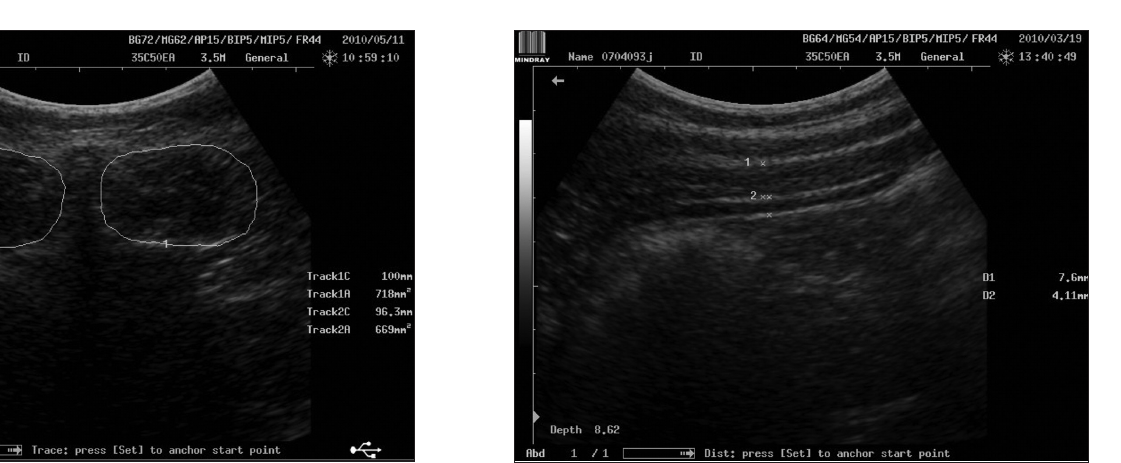
Figure 1: Image of Lumbar Multifidus at L4 with Ultrasound Imaging In the above image the internal caliper of the ultrasound unit was used to trace the circumference. This was 100mm (10cm) for the right side of the LM, from which a CSA of 718mm² (7.18cm²) is estimated. On the left side the circumference was 96.3mm (9.63cm) and the CSA 669mm² (6.69cm²). During the recording of LM, the resting shape (oval) was also noted for qualitative analysis.